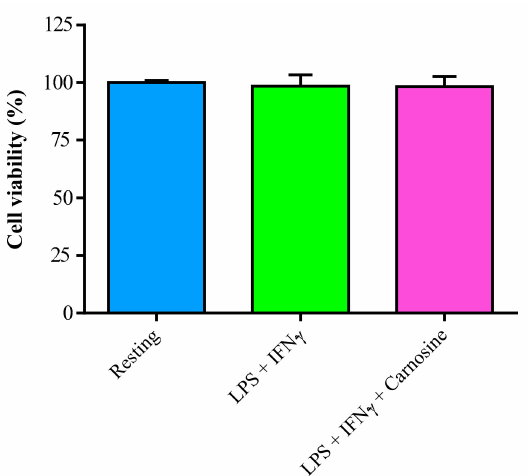
Figure 1. Cell viability in resting (control) RAW 264.7 macrophages and in RAW 264.7 macrophages stimulated with LPS (100 ng / mL) + IFN- γ (600 U / mL), in the absence or in the presence of carnosine (20 mM). Data are the mean of five independent experiments. Values were normalized with respect to control untreated macrophages (resting) and are expressed as the percent variation of cell